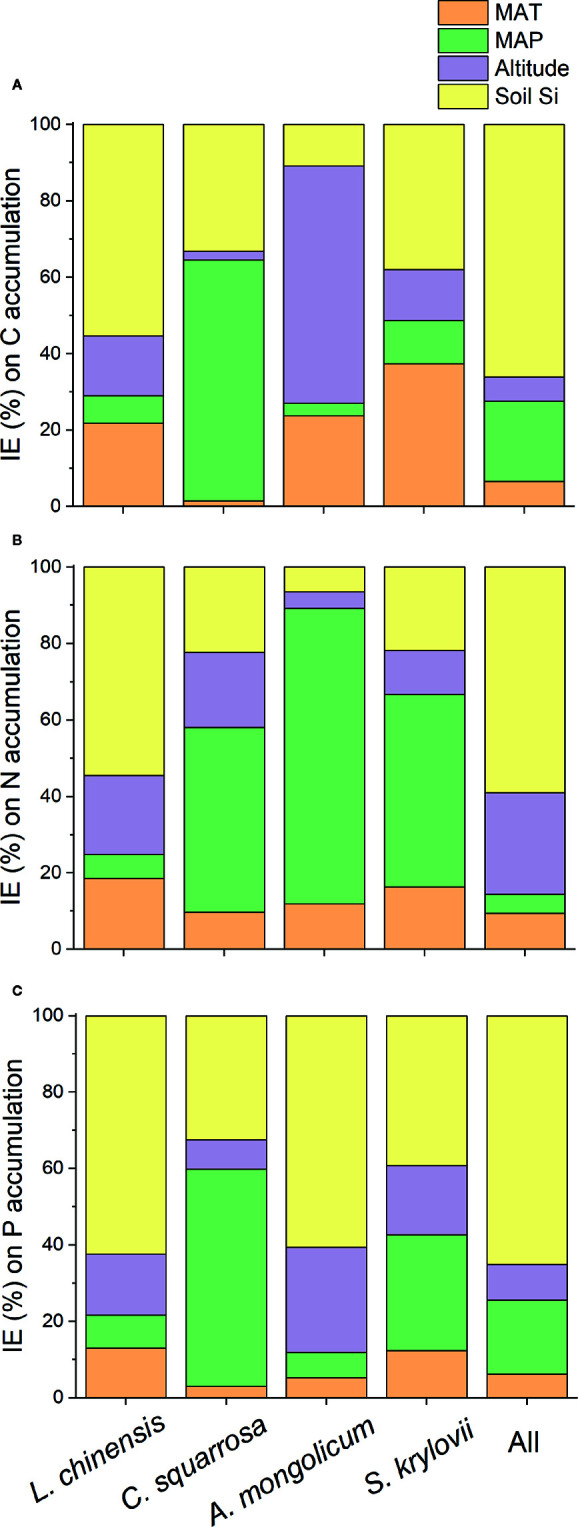
The independent effect (IE; %) of environmental factors (MAT, MAP, altitude, and soil noncrystalline Si) on C (A), N (B), and P (C) accumulation based on hierarchical variation partitioning (HP).